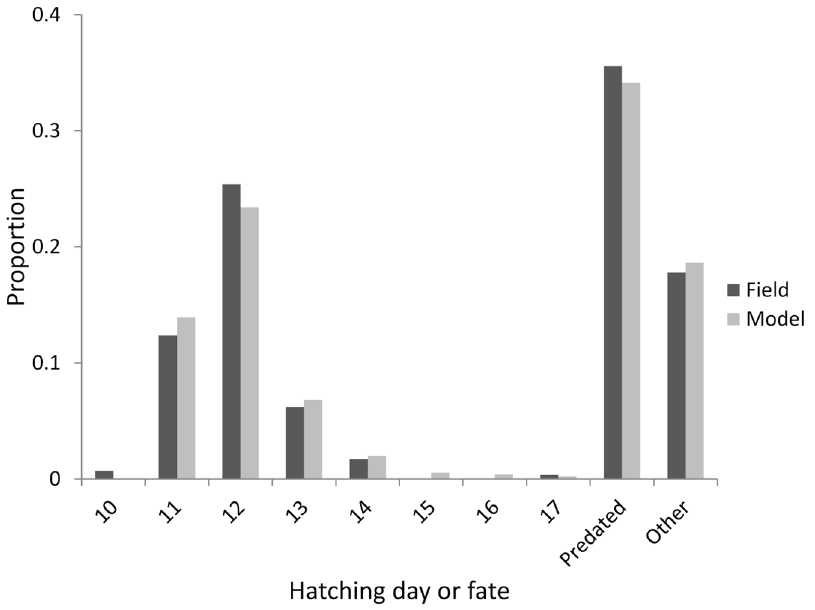
Figure 3. Comparison of the hatching day of successful clutches (minimum one egg hatched), and causes of nest failure observed in the Kalø study area and those predicted by the ALMaSS skylark model.